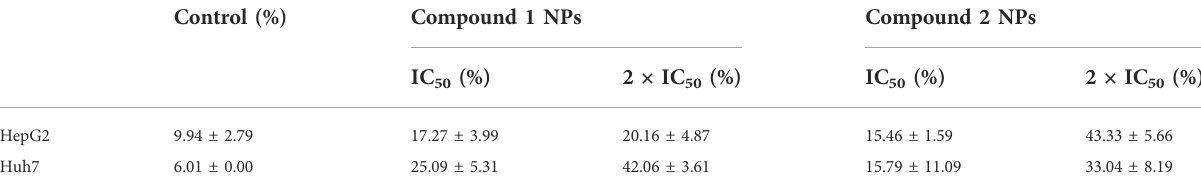
TABLE 4 Apoptosis rate of compounds 1 and 2 NPs on HepG2 and Huh7